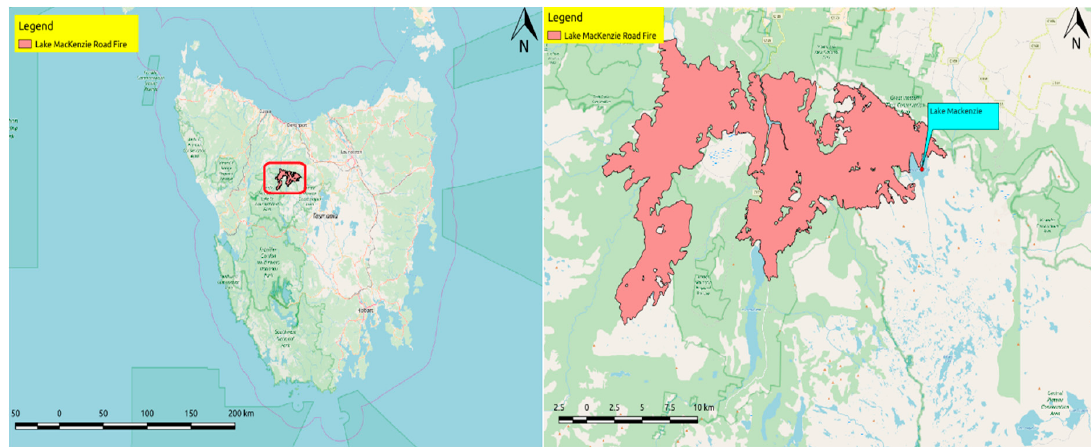
Figure 1. Location of Lake Mackenzie overlaid with Open Street Map (OSM) standard map. A regional map highlighting the location of Lake Mackenzie is displayed ( left ), together with the fire boundary and surrounds ( right ).